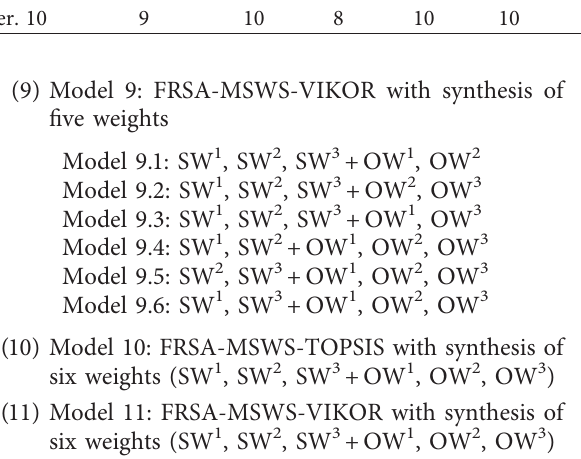
(9) Model 9: FRSA-MSWS-VIKOR with synthesis of